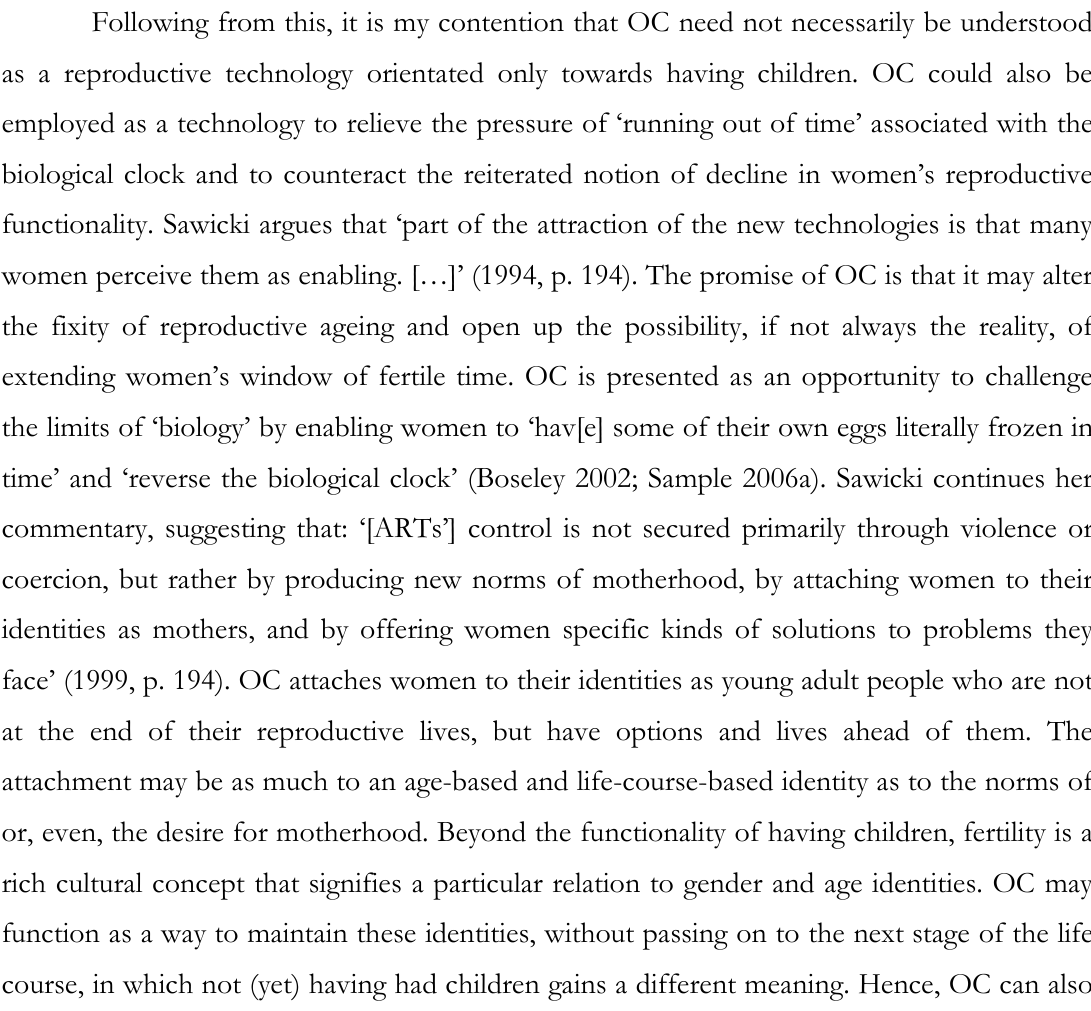
Lucy van de Wiel, For Whom The Clock Ticks: Reproductive Ageing and Egg Freezing in Dutch and British News